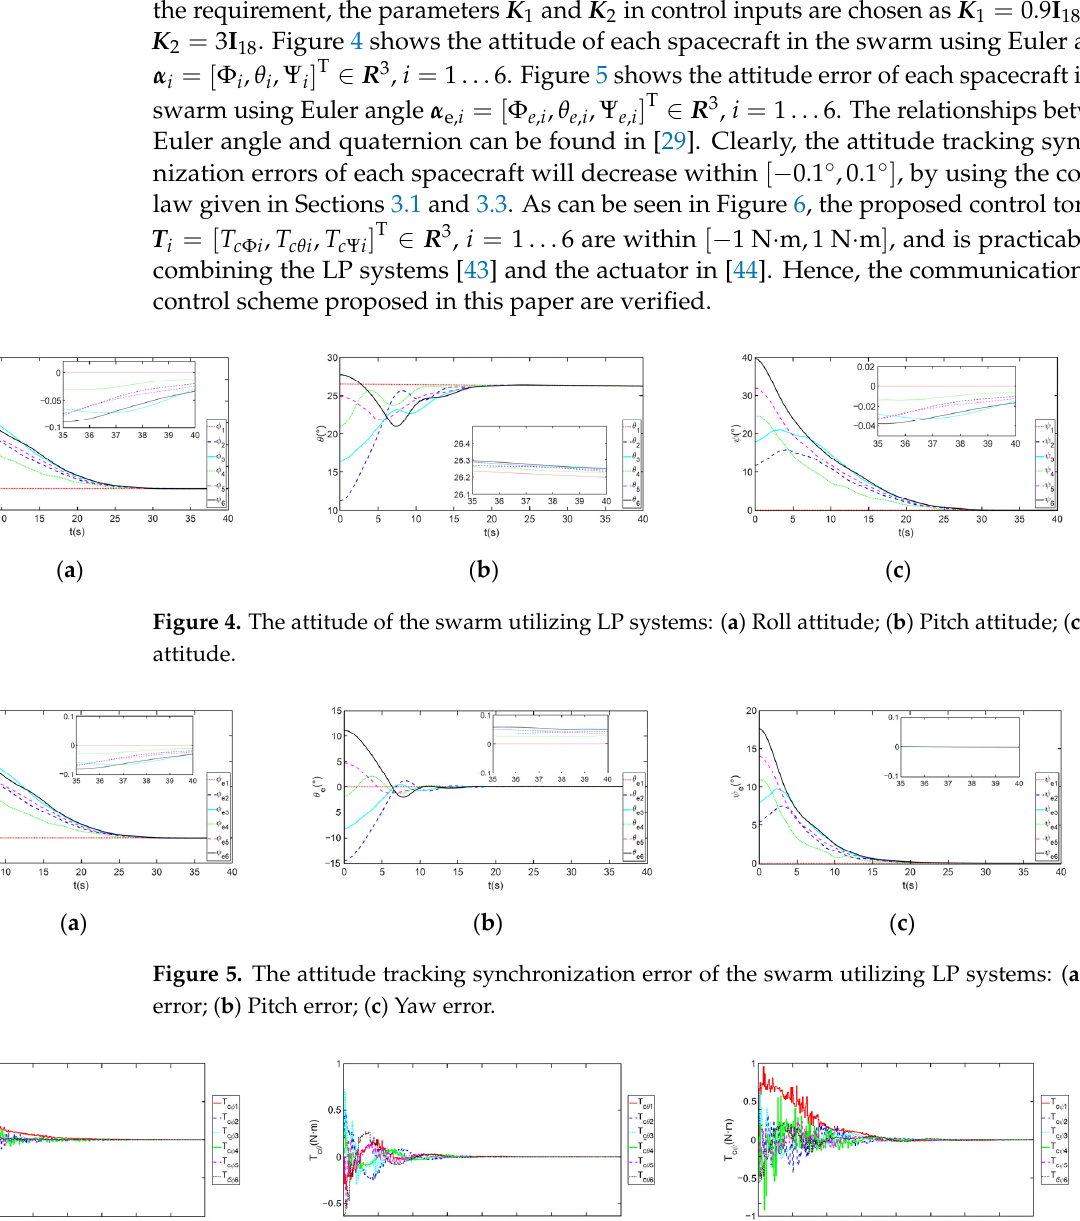
Table 1. Orbit elements of the target and spacecraft.